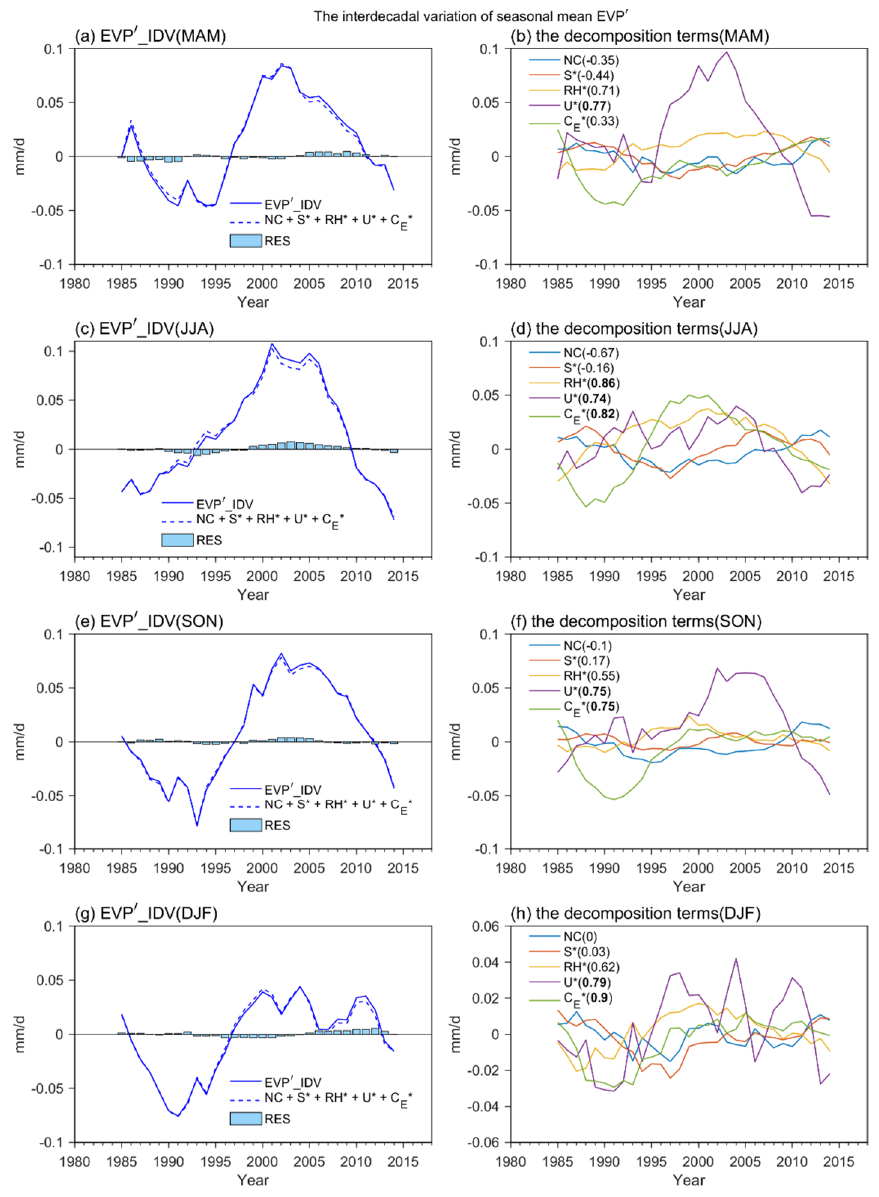
Figure 4. As in Figure 3, for ( a , b ) MAM, ( c , d ) JJA, ( e , f ) SON, and ( g , h ) DJF. To investigate the impacts of climate modes on the IDV of EVP (cid:4593) , we calculated the correlation between the IDVs of major climate modes (PDO, AMO, and NAO) and the annual mean EVP (cid:4593) and the related decomposition terms (Figure 5). The correlations between the IDV of RH*, U*, and AMO were 0.88 and 0.89 (above the 95% confidence level), respectively. The results indicate that the AMO contributed to the increased EVP (cid:4593) in the 1990s and the decreased EVP (cid:4593) after the early 2000s by affecting the RH* and U* (Figure 5a). The correlation between the IDV of C E * and NAO was − 0.8 (above the 95% confidence level), suggesting that the NAO contributed to the decreased EVP (cid:4593) in the 1980s and the increased EVP (cid:4593) in the 1990s by affecting the C E * (Figure 5b). The correlation between the IDVs of EVP (cid:4593) and PDO was − 0.76, which was significant with the 95% confidence level. However, the IDVs of other terms were not significantly correlated with the IDV of PDO (Figure 5d). The 9-year running correlation between the IDVs of U* and PDO was compa- rable to that of the IDVs of RH*, U*, and AMO in the 1990s, but showed a shape decrease after the early 2000s (Figure 5c). The results indicate that the PDO contributed to the in- creased EVP (cid:4593) in the 1990s by affecting the U*. Therefore, the NAO plays an important